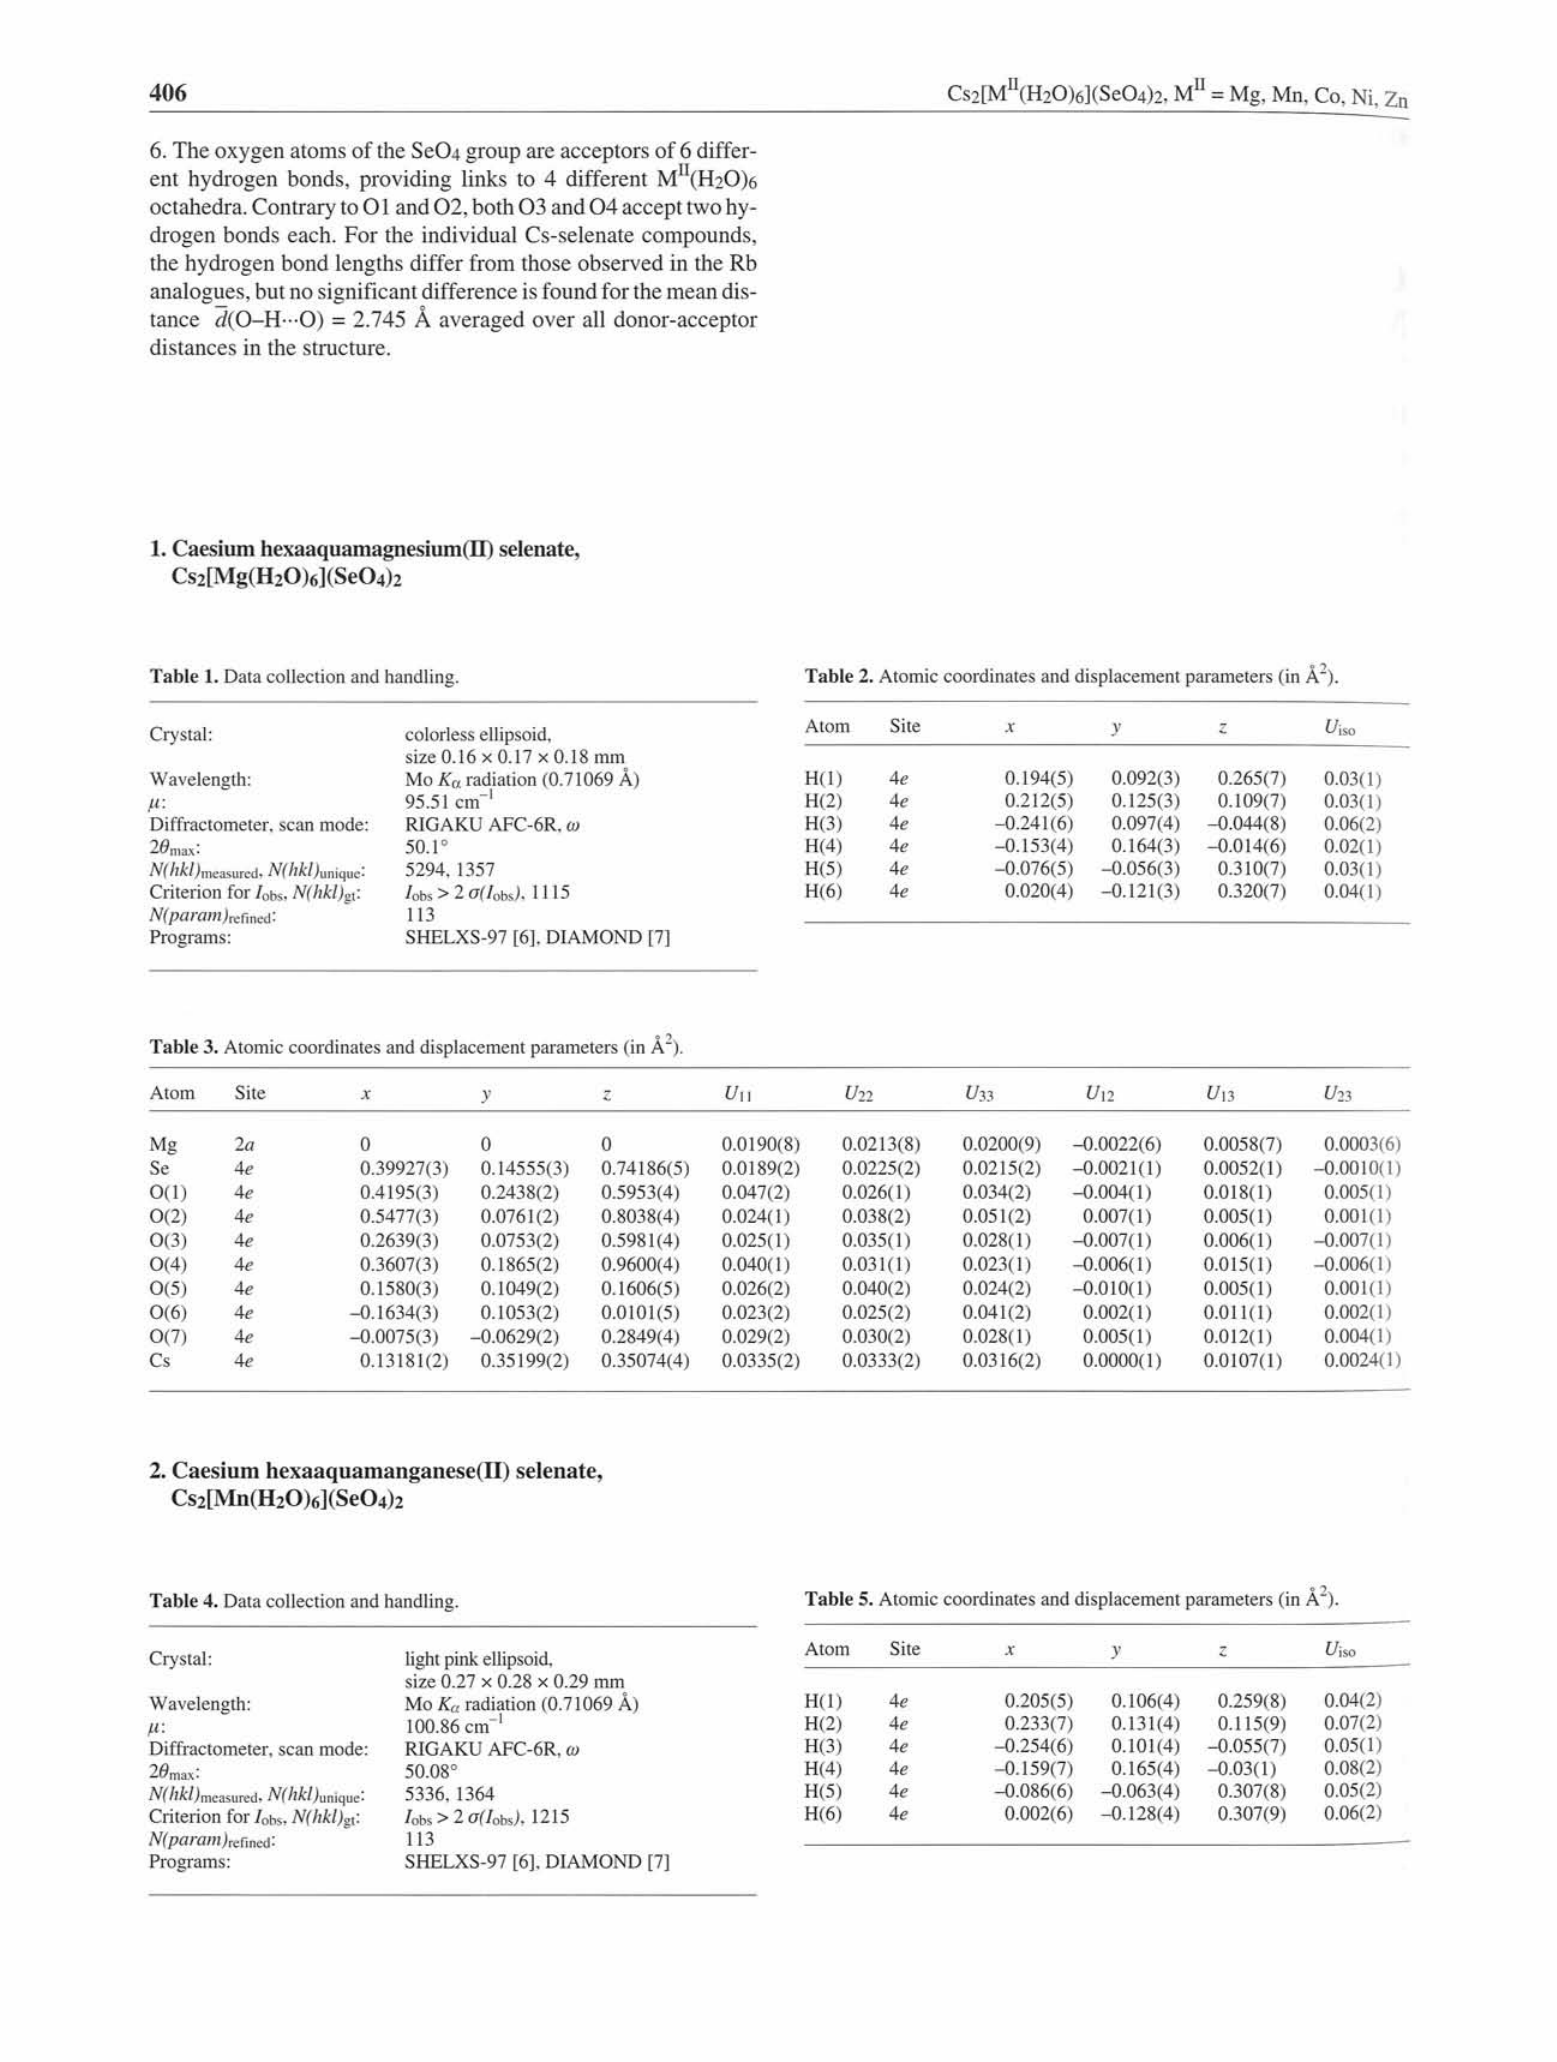
Table 4. Data collection and handling. Table 5. Atomic coordinates and displacement parameters (in